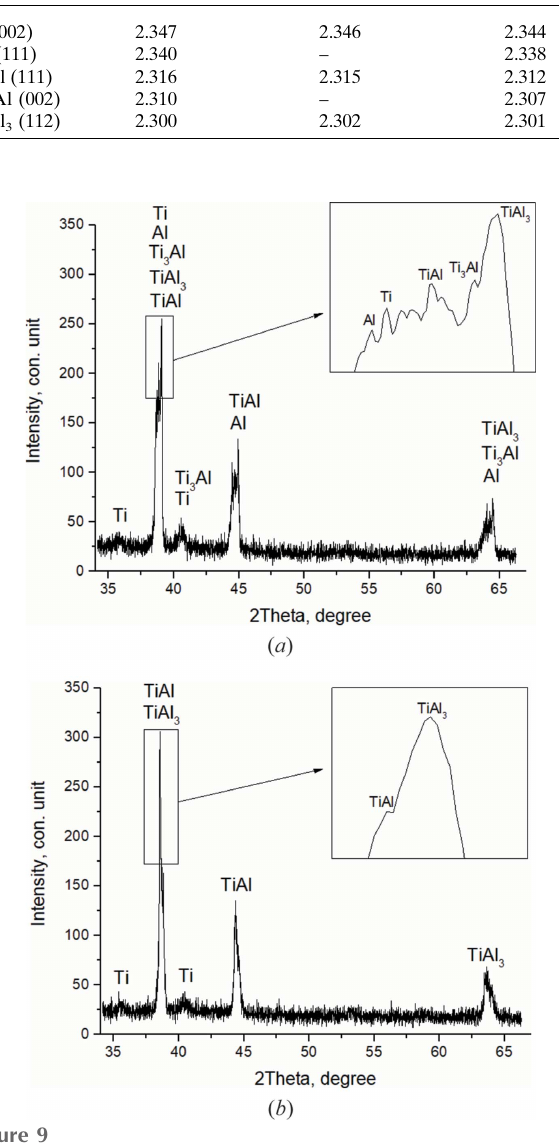
Figure 9 Diffractograms of the 21st ( T = 661 (cid:3) C) ( a ) and the 22nd ( T = 662.9 (cid:3) C) ( b ) shots.